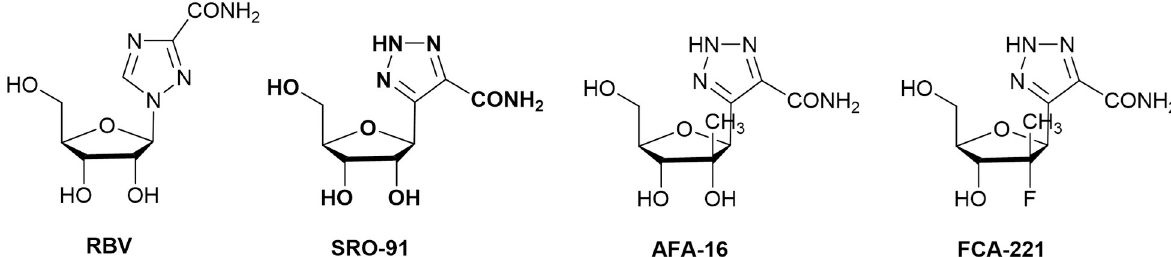
Fig 1. Structure of ribavirin (RBV), SRO-91, AFA-16 and FCA-221 analogs.